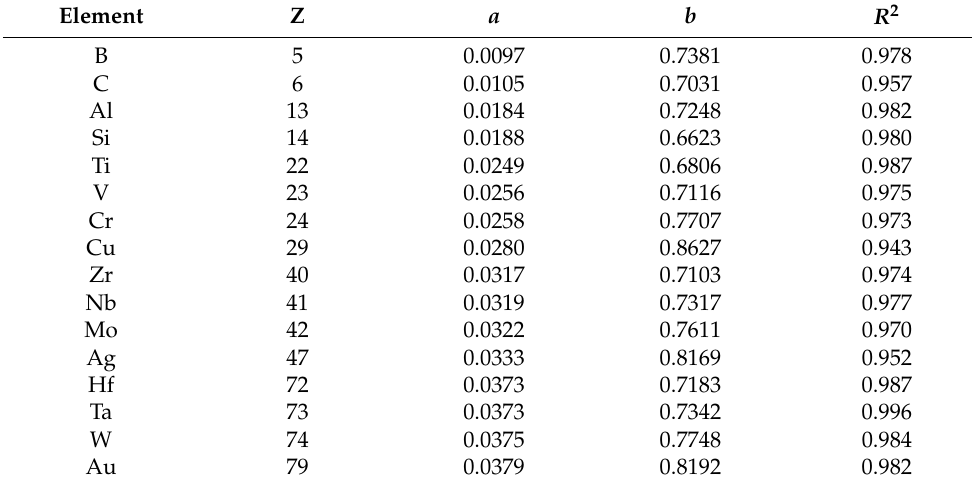
Table 4. Parameter a calculated from Equation (21), power parameter b for fitting the sputtering yield in dependence of ion energy, and coefficient of determination R 2